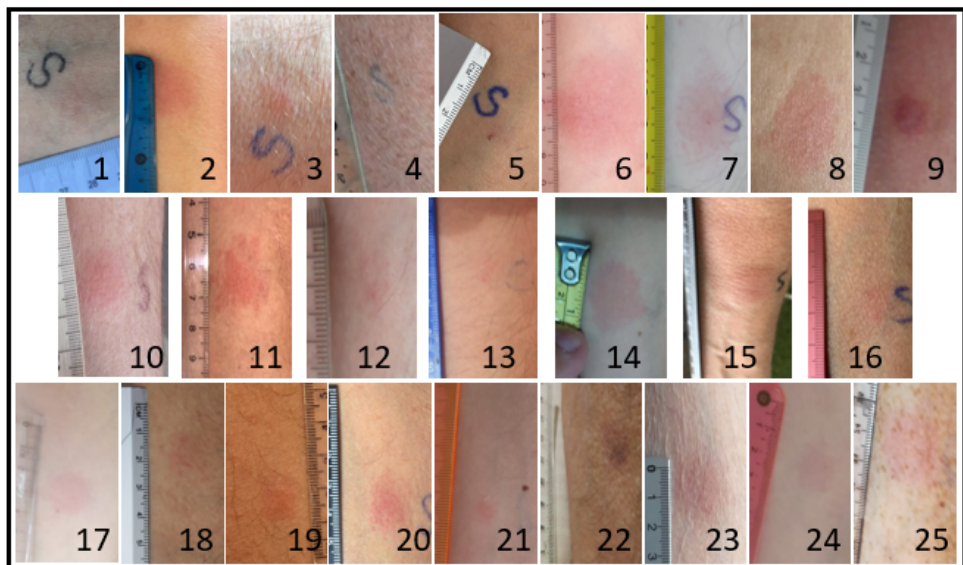
Vaccines 2021 , 9 , x FOR PEER REVIEW Figure 2. Samples of the photographs of the response in the arm of each of the 25 patients after 48 h of the DTH test.